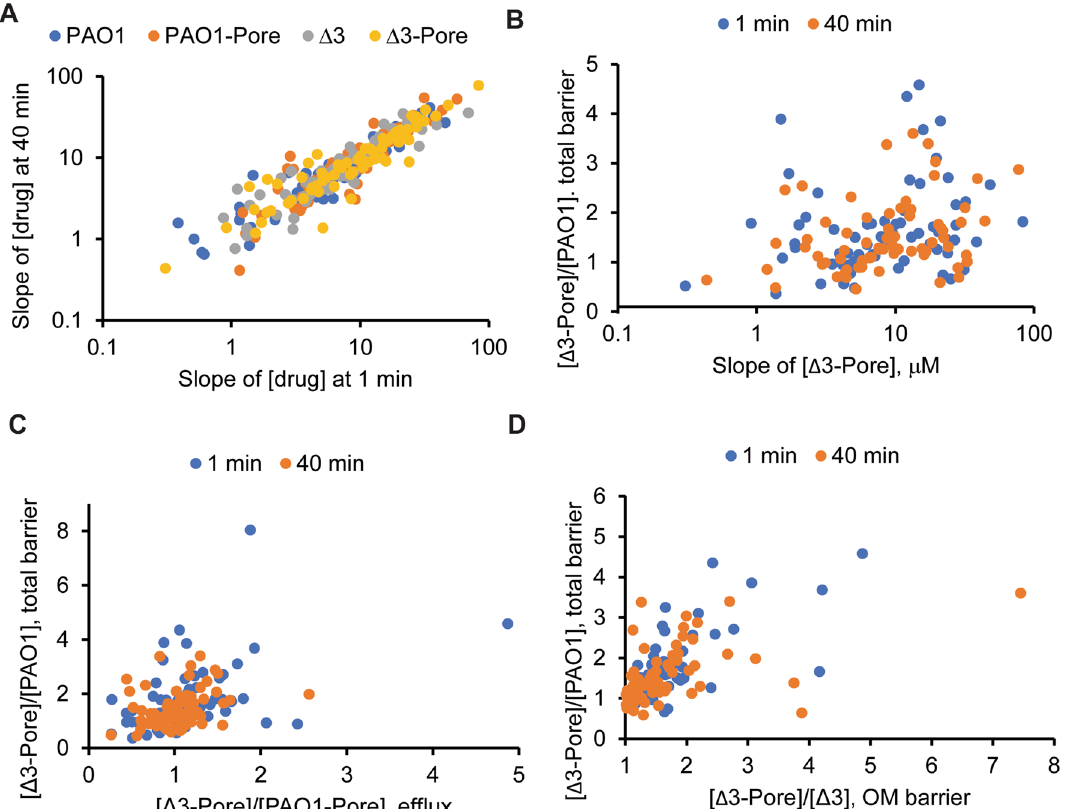
Figure 3. Intracellular accumulation of the analyzed library of 66 compounds. ( A ) Slopes of intracellular accumulation of compounds at 1 min and 40 min incubation times. ( B ) Plot of the slopes of measured intracellular accumulation in the “barrierless” strain as a function of the fold difference in accumulation in PAO1 and “barrierless” strain. ( C ) and ( D ) Comparison of fold change in the compound accumulation for the PΔ3-Pore/PAO1 (Total barrier) and PΔ3-Pore/PAO1-Pore (Efflux) or PΔ3-Pore/PΔ3